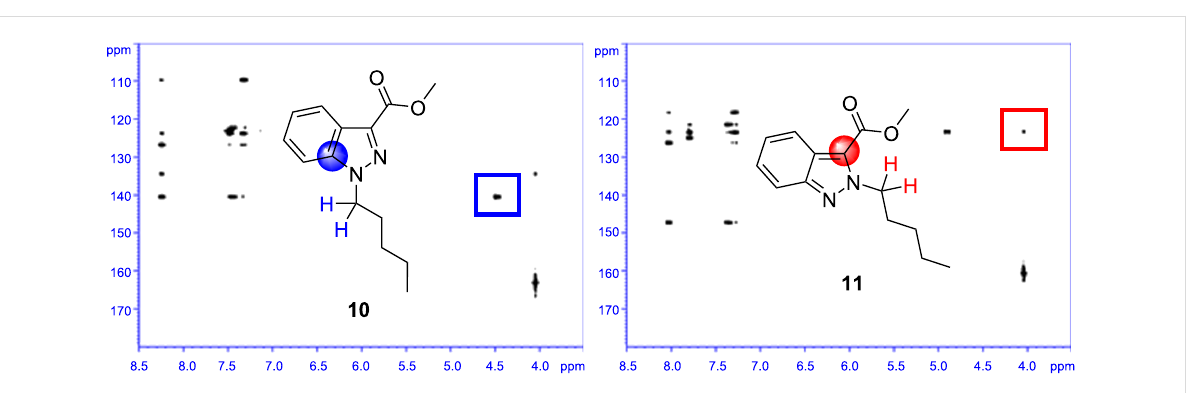
Figure 2: Observation of a 1 H– 13 C correlation between the C-7a (blue circle) or C-3 (red circle) atom of the indazole ring and the N - n -pentyl CH 2 proton pair proximal to N atoms of the indazole nucleus, using ( 1 H– 13 C) HMBC NMR experiments, permitted the regiochemical assignment of N -1 and N -2 substituted regioisomers 10 and 11 ,